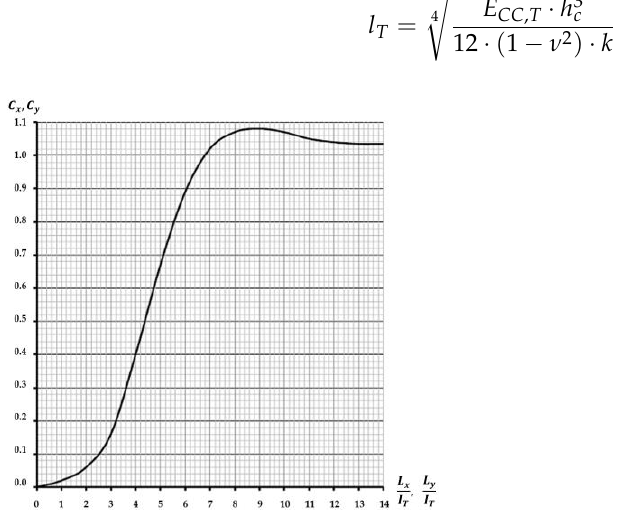
Figure 9. Graph for the determination of the C x (C y ) coefficient according to TP 098. Reprinted with permission from [45]. Copyright 2022 by the Slovak road administration.